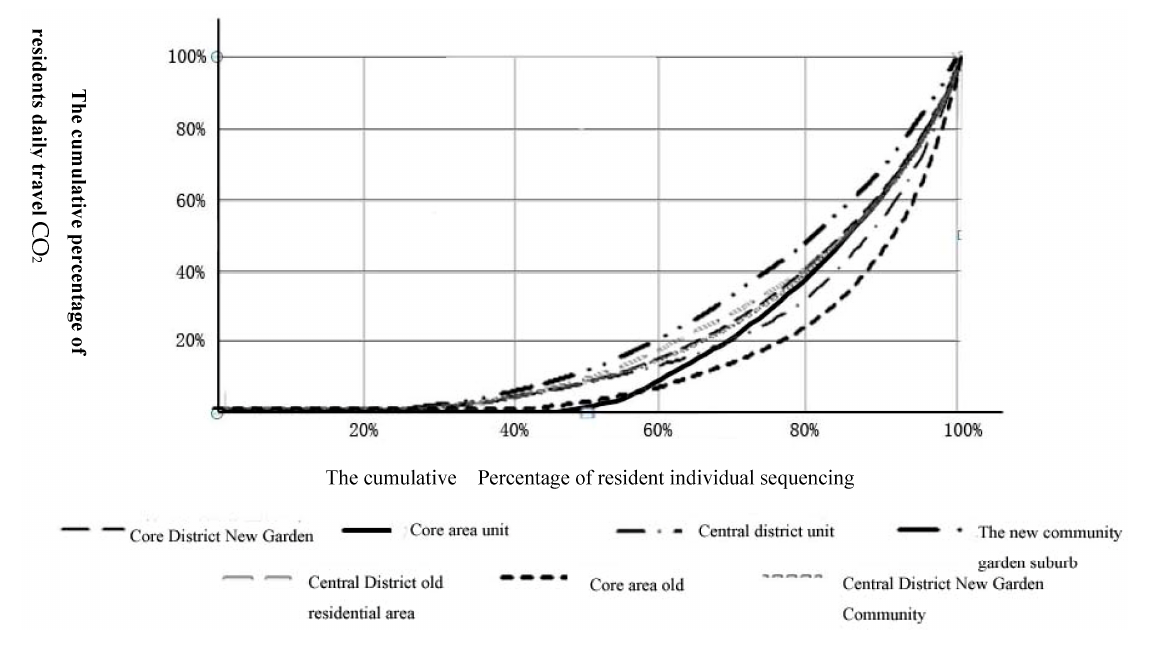
Figure 6. Lorenz curve of residents’ travel carbon emissions in different types of communities.